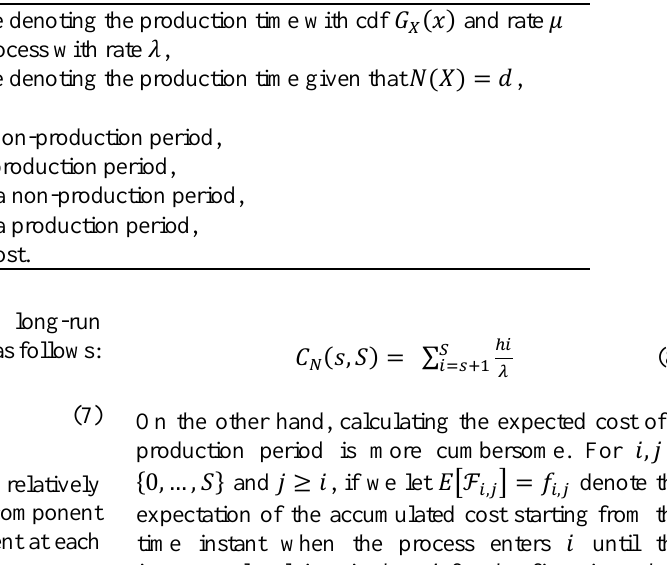
Table 2. Basic notation of the renewal